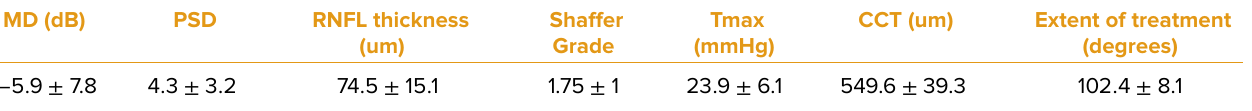
Shaffer Tmax CCT (um) Extent of treatment (um) Grade (mmHg) (degrees)